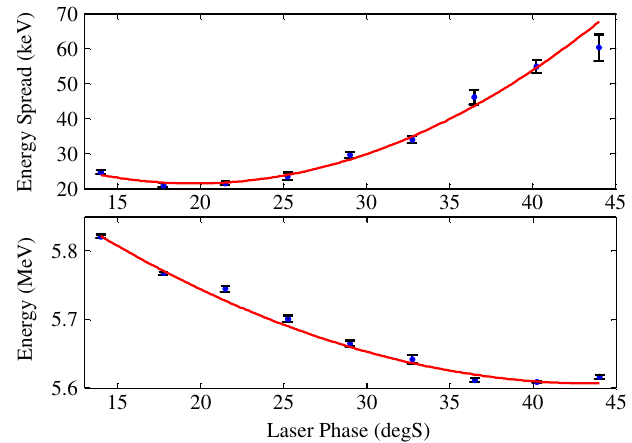
FIG. 9. (Color) The rms energy spread (top) and energy (bot- tom) as a function of laser phase. Here the cathode peak field was 110 MV = m and laser pulse length 6 ps FWHM. Red curves are a parabolic fit to the